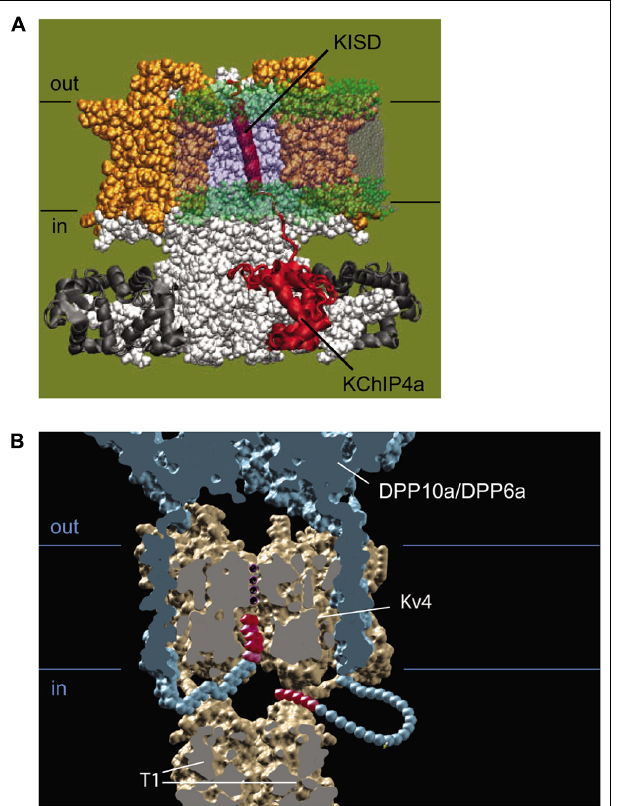
FIGURE 5 | Molecular mechanism of functional regulation by KChIP4a, DPP6a, and DPP10a. (A) Working molecular model of the transmembrane Kv-channel inactivation suppressor domain (KISD) inserting through the membrane and making contacts with the Kv4 channel core, as adapted from Jerng and Pfaffinger (2008). As reported byTang etal. (2013), separate domains within the KISD determine ER retention and regulation of channel gating. KChIP4a is shown in red, voltage sensors in yellow, and the remaining Kv4 channels in white. (B) Side view of a model illustrating the basis for fast inactivation mediated by DPP6a and DPP10a.Two of the four subunits have been removed to reveal the inner channel structure, including the permeation pathway with K + , DPLP extracellular and transmembrane domain (blue), and the DPLP N-termini with inactivation particles